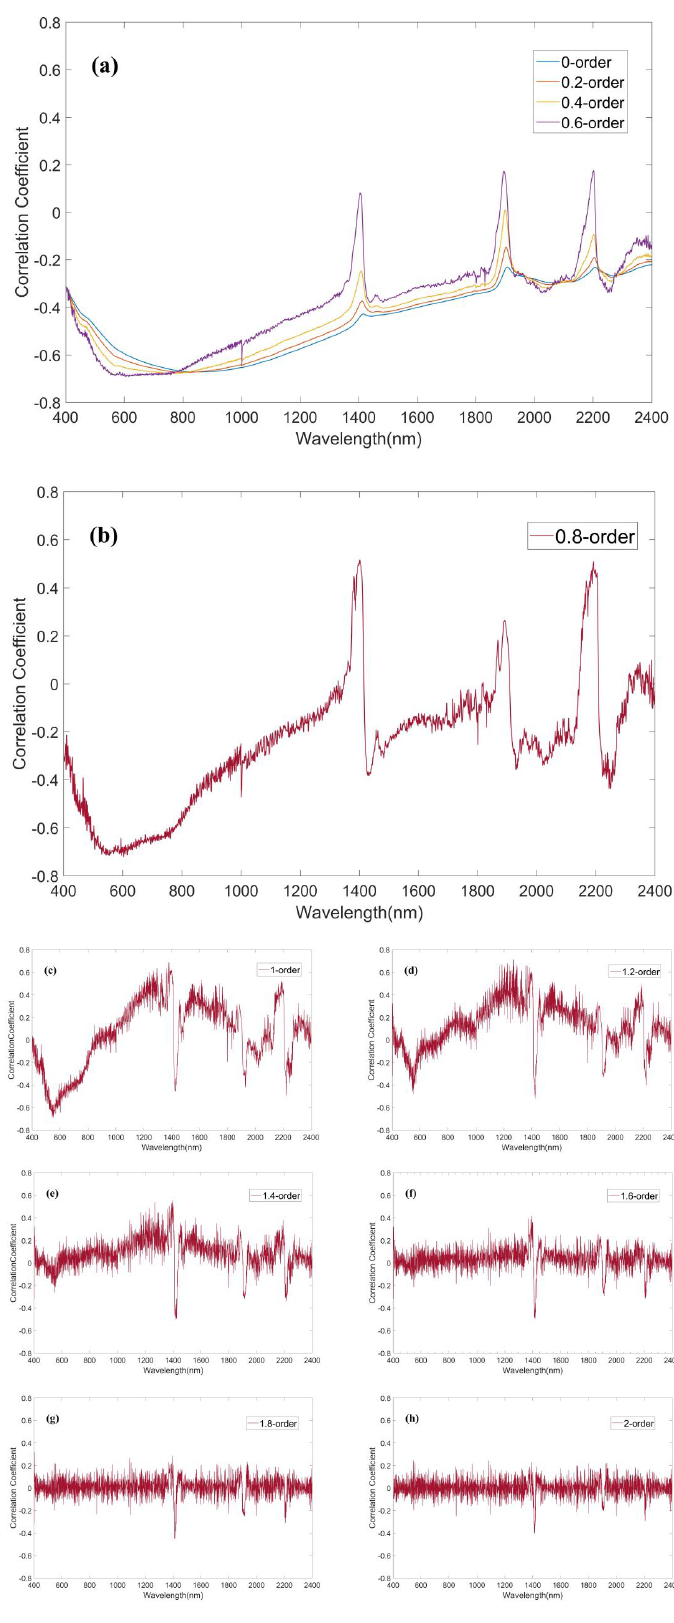
Figure 3. Correlation curves between soil organic content and original spectrum preprocessed by fractional derivatives in (a) 0–0.6 order, ( b ) 0.8 order, ( c ) 1 order, ( d ) 1.2 order, ( e ) 1.4 order, ( f ) 1.6 order, ( g ) 1.8 order, and ( h ) 2 order.